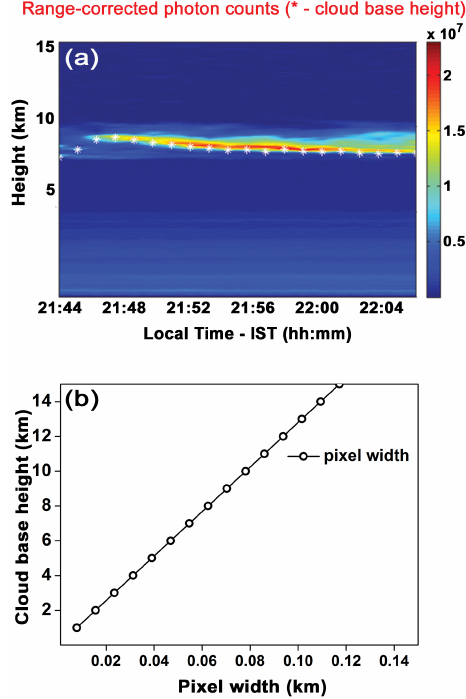
Figure 4. (a) Height-time variation of range corrected photon count (shading) showing the CBH variation (white stars) on April 17, 2012. (b) Vertical profile of pixel width calculated using the CBH.